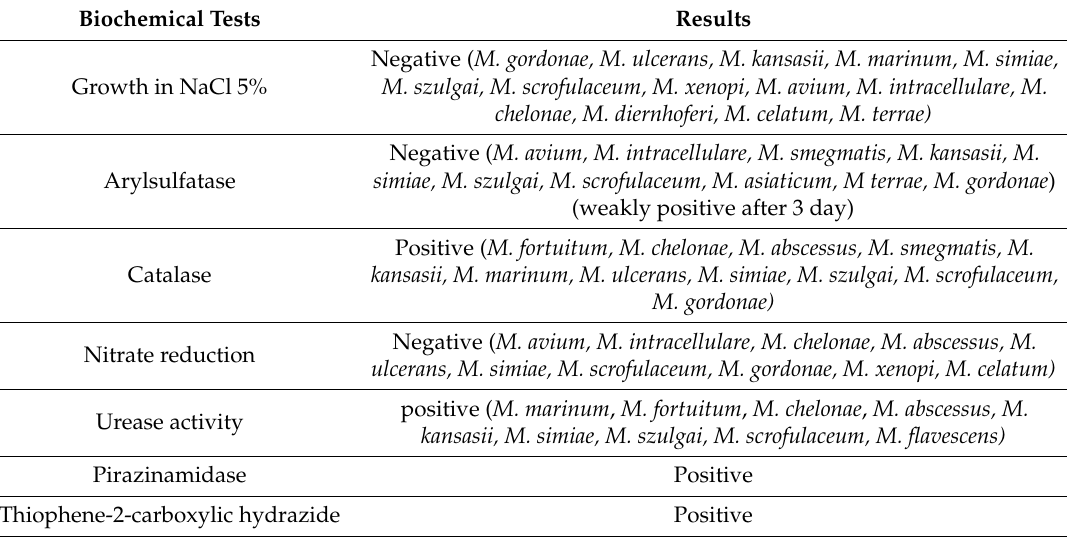
Table 2. Biochemical test for the identification of Mycobacterium